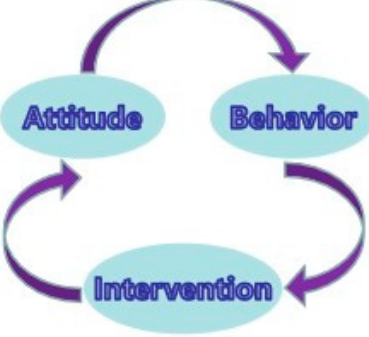
Figure 1. Attitude–behavior–intervention feedback loop.